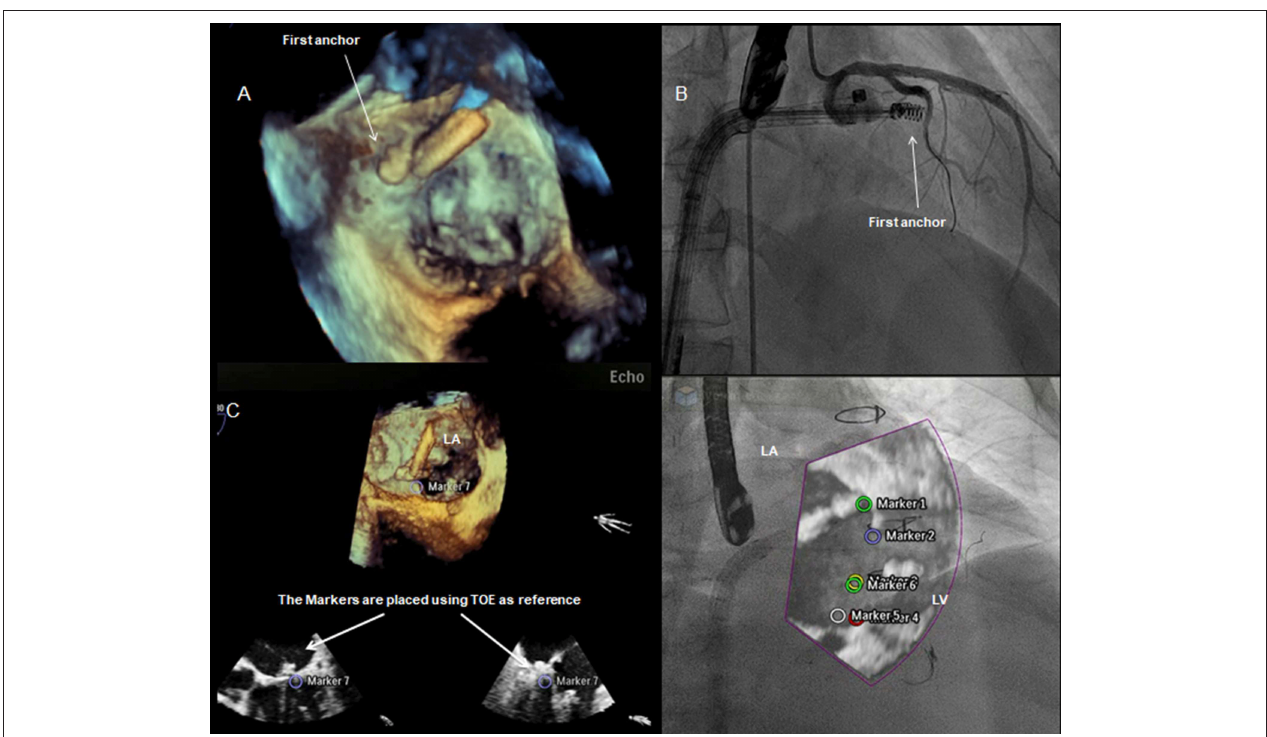
FIGURE 11 | Integrated intra-procedural guidance for Cardioband: (A,C) real-time 3D transesophageal echocardiography facilitates the navigation and delivery of the first anchor; (B) fluoroscopy: the use of coronary wire may serve as a radiographic marker and a potential railway for bailout strategies. Fusion imaging allows to display an overlap image of the “echo-structures” in the fluoro-images. This could be a valuable tool in the presence of difficult anatomies and in the first phase of the operator’s learning